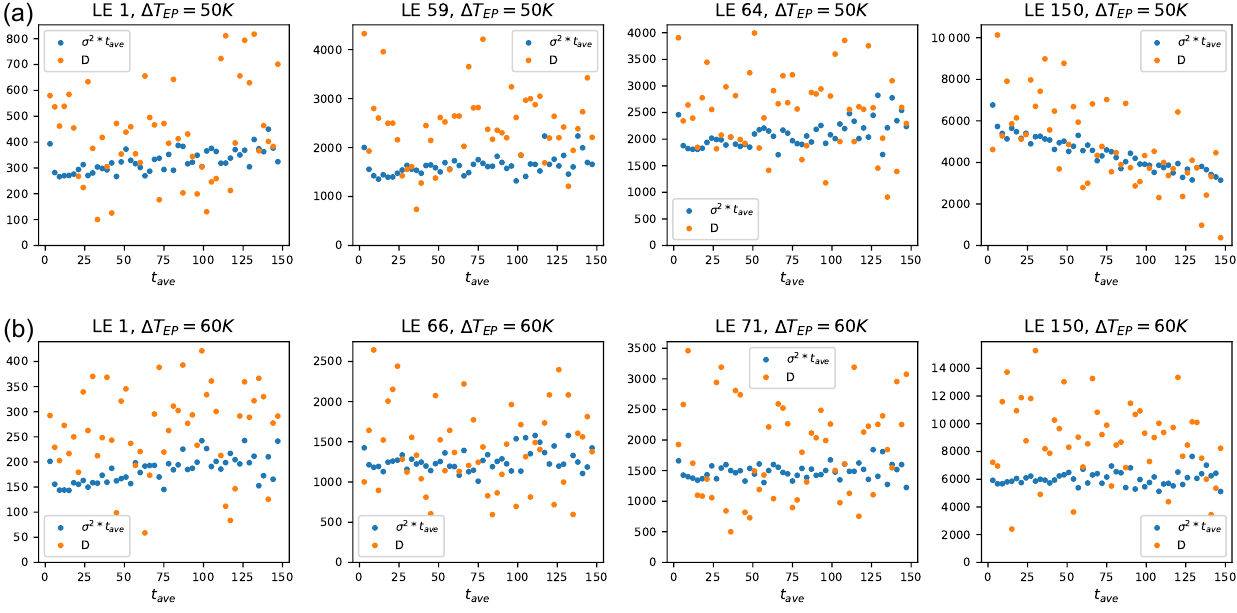
Figure A2. The metric σ 2 · t ave versus the diffusion coefficient D , derived from the inverse of the second derivative at the minimum of the rate function, as a function of the block averaging length t ave for different Lyapunov exponents of the PUMA model. The Lyapunov index is shown in the title. Panels (a) show the results for a temperature gradient of 50K, panels (b) for